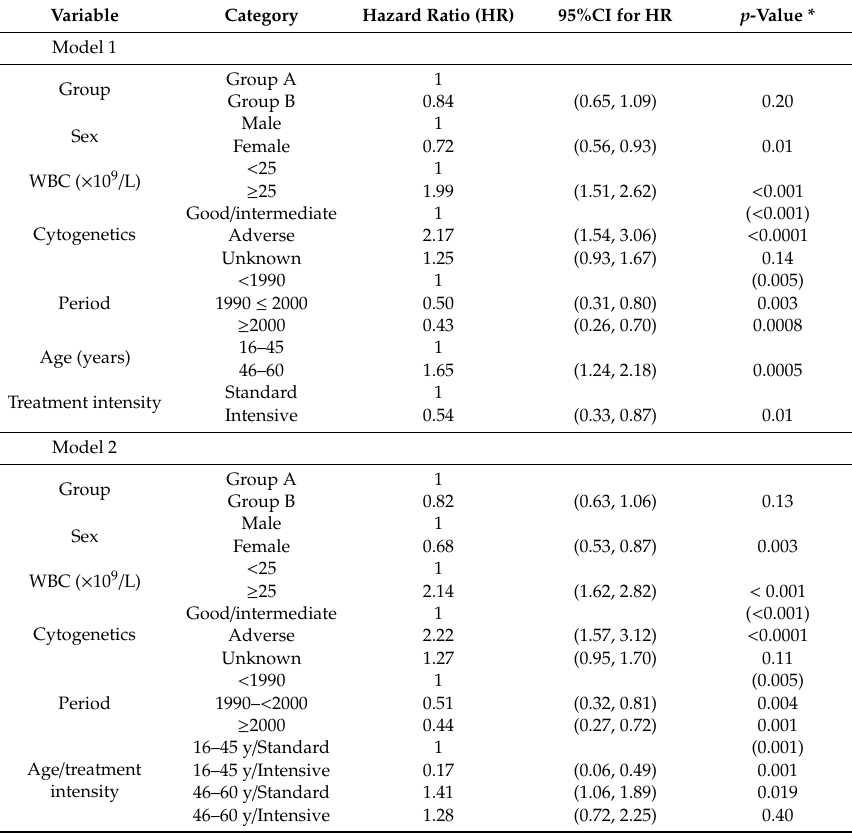
Table 2. Results of the multivariable Cox model for OS in patients with s-AML following MDS (group A) or other malignancies (group B) and aged 16–60 years at the start of